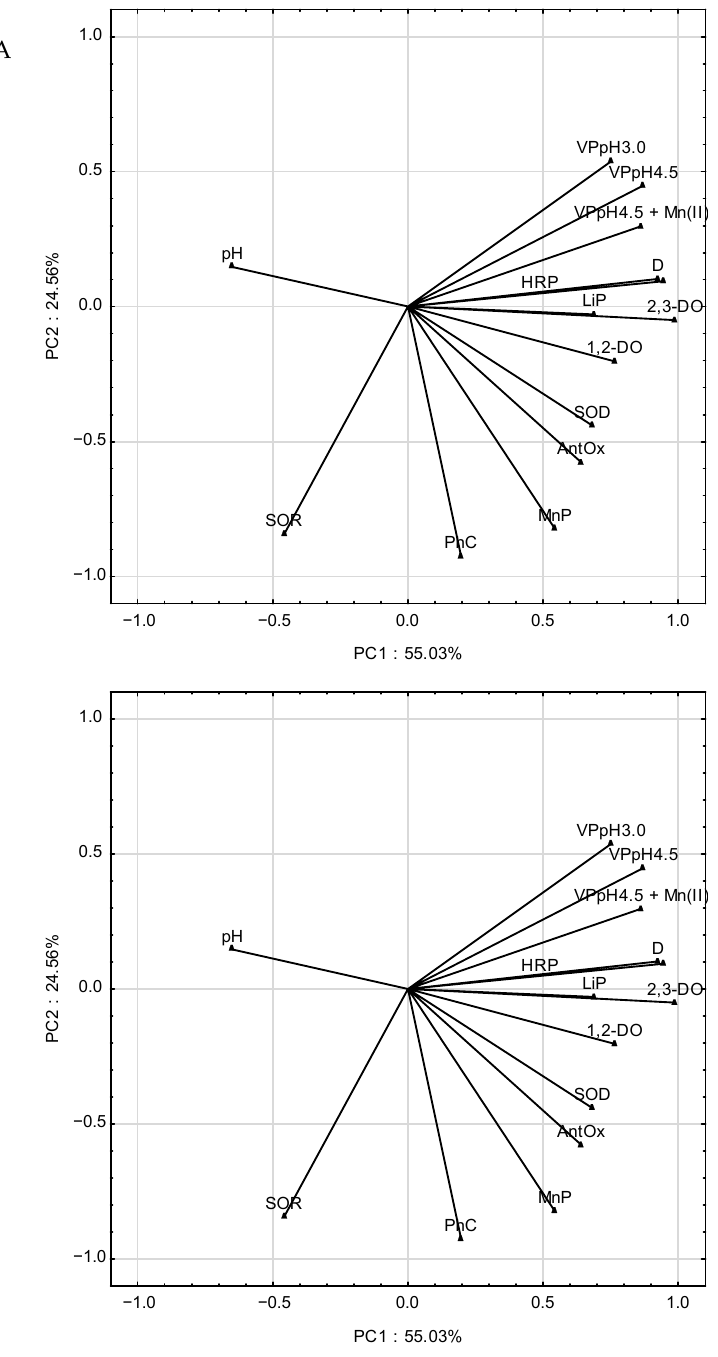
Figure A4. Plot of variables. Location of load vectors towards two principal components for cultures of strain of B. adusta CCBAS 930 with DNR ( A ) and DOX ( B ); 1,2-DO (1,2-dioxygenase), 2,3-DO—(2,3-dioxygenase), CAT (catalase), D—decolorization, GOX (glucose oxidase), HRP-like (horsheradish-type peroxidase), LiP (lignin peroxidase), MnP (manganese-dependent peroxidase), PhC (phenolic compounds), SOD (superoxide dismutase), SOR (superoxide radical levels), VP (versatile peroxidases activity measurement without Mn +2 in pH = 3.0 and pH = 4,5 and with Mn +2 in pH = 4.5).